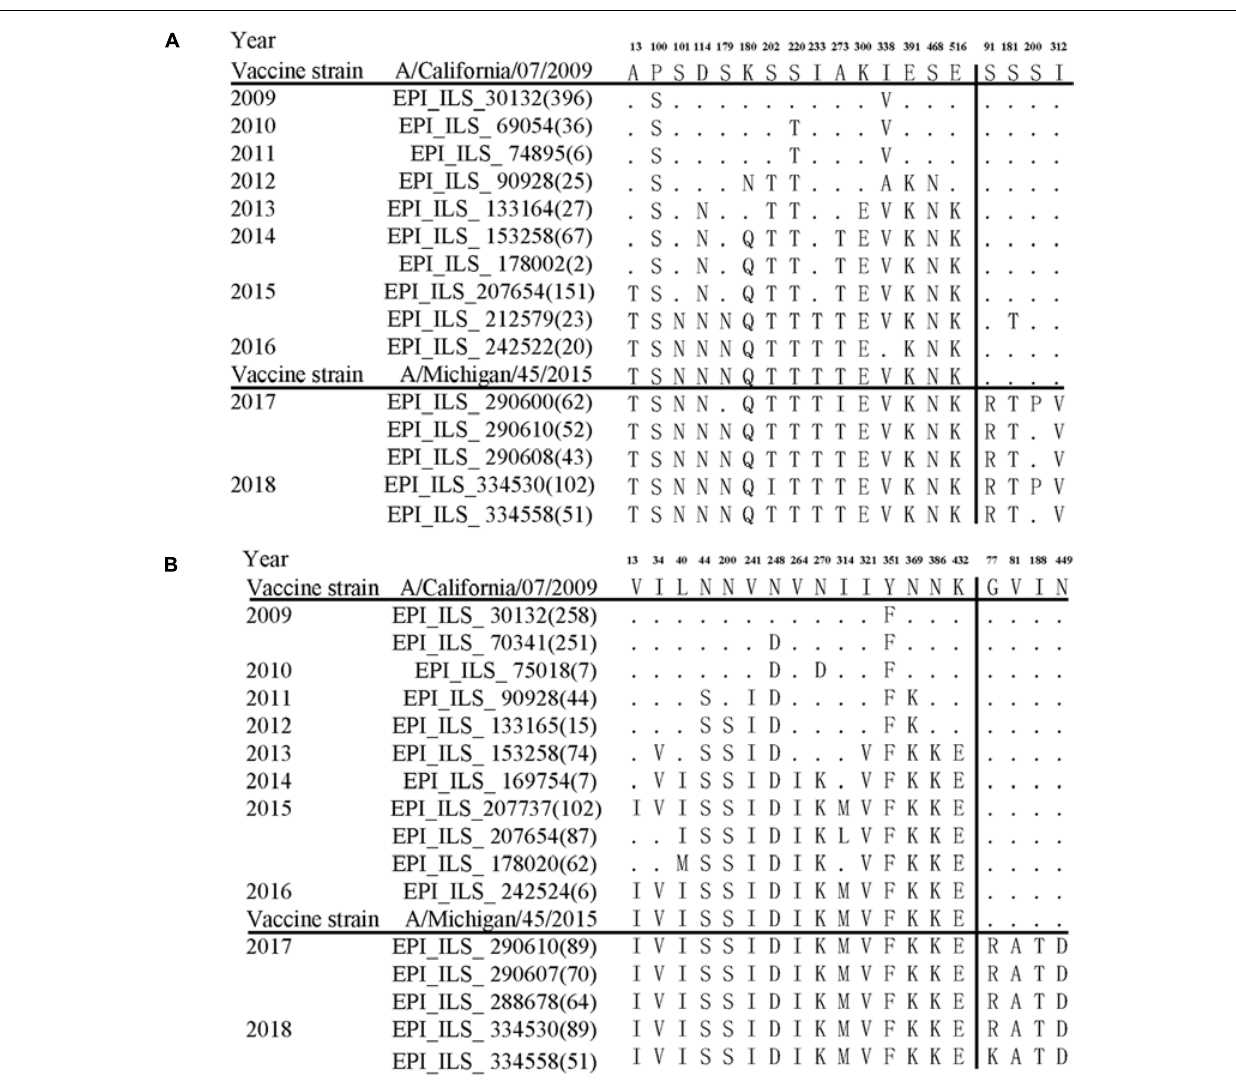
FIGURE 4 | Amino acid variations of HA (A) and NA (B) glycoproteins of A/H1N1pdm virus during 2009–19 compared to the vaccine strains. The small dots indicate identical amino acids to the vaccine stain A/California/07/2009. The number of identical sequences is shown in